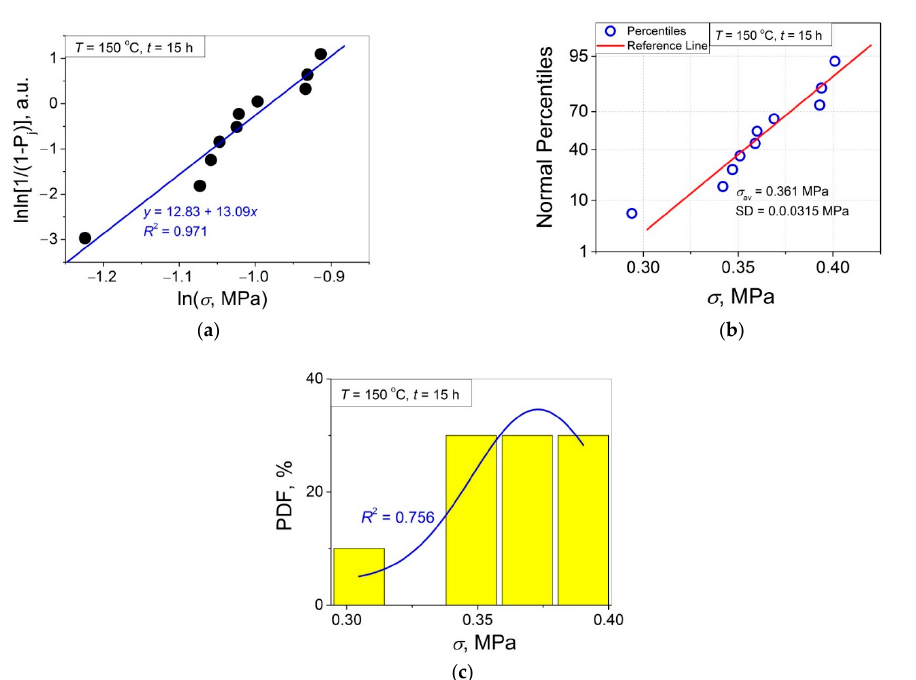
Figure 13. ( a ) Linear regression fit of the lap shear strength σ in Weibull’s coordinates; ( b ) normal probability plot; ( c ) probability density function (PDF) vs. σ fitted with a Gaussian function for an amorphous PET–PET interface self-bonded at T = 150 °C for t = 15 h.